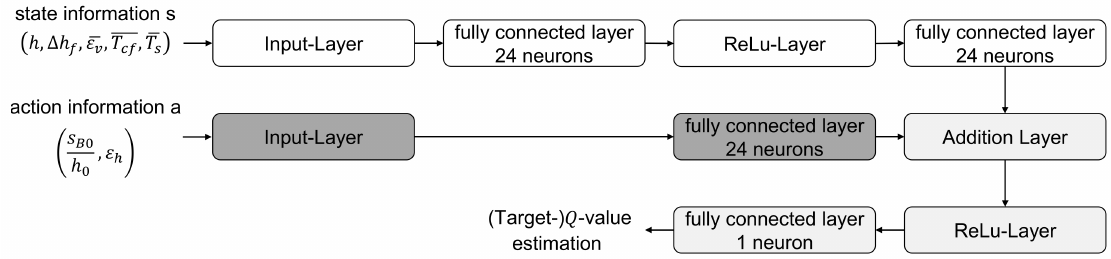
Figure 5. Graphic representation of the used